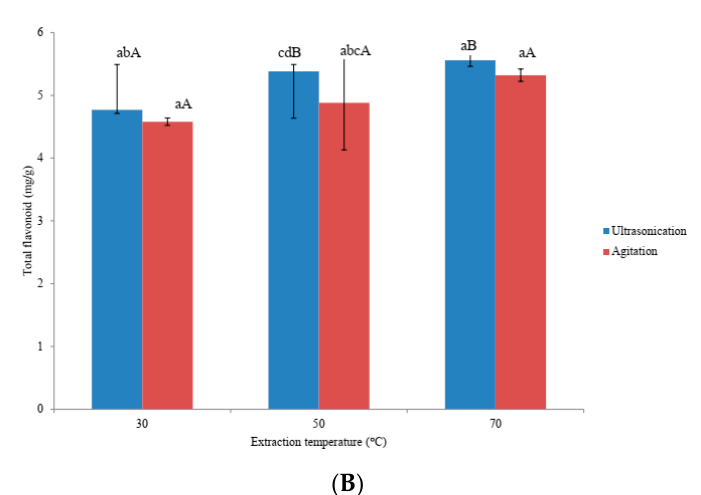
Figure 2. Effects of ultra-sonication and agitation on total phenol and total flavonoid content of amaranth extract. ( A ) Total phenol content ( B ) Total flavonoid content. a-d Means with same subscript alphabets are not significantly different ( p ≤ 0.05) between each extraction method. A-C Means with same subscript alphabets are not significantly different ( p ≤ 0.05) among different temperatures in each extraction method.